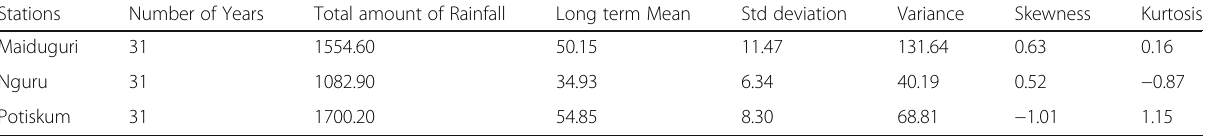
Table 3 Summarized rainfall statistics for the study area (Maiduguri, Nguru and Potiskum